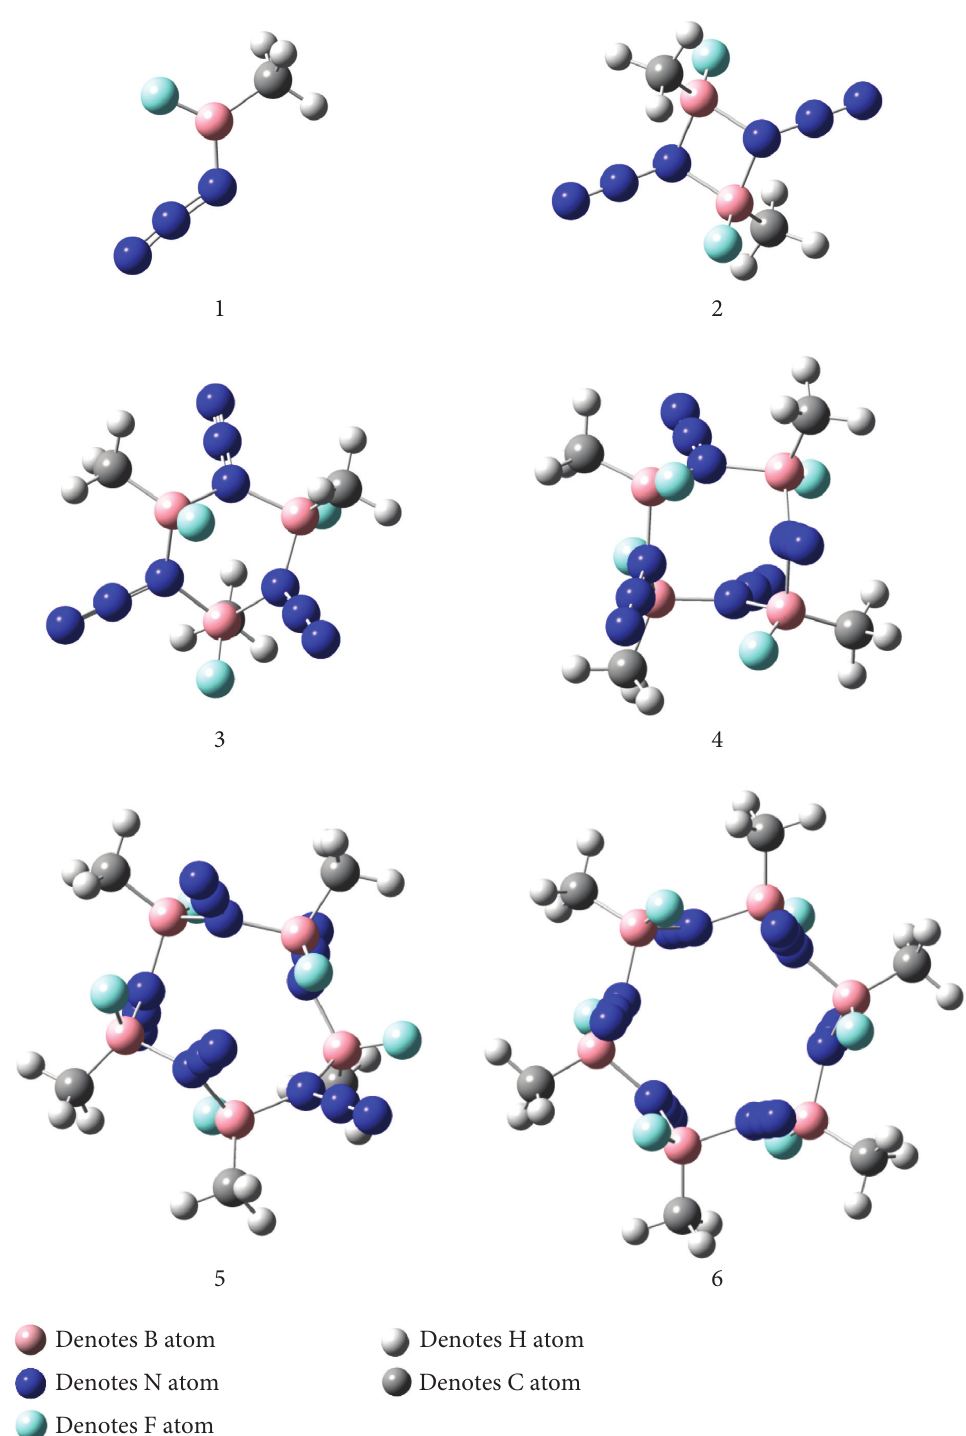
Figure 1: Structures of the asymmetric clusters (CH